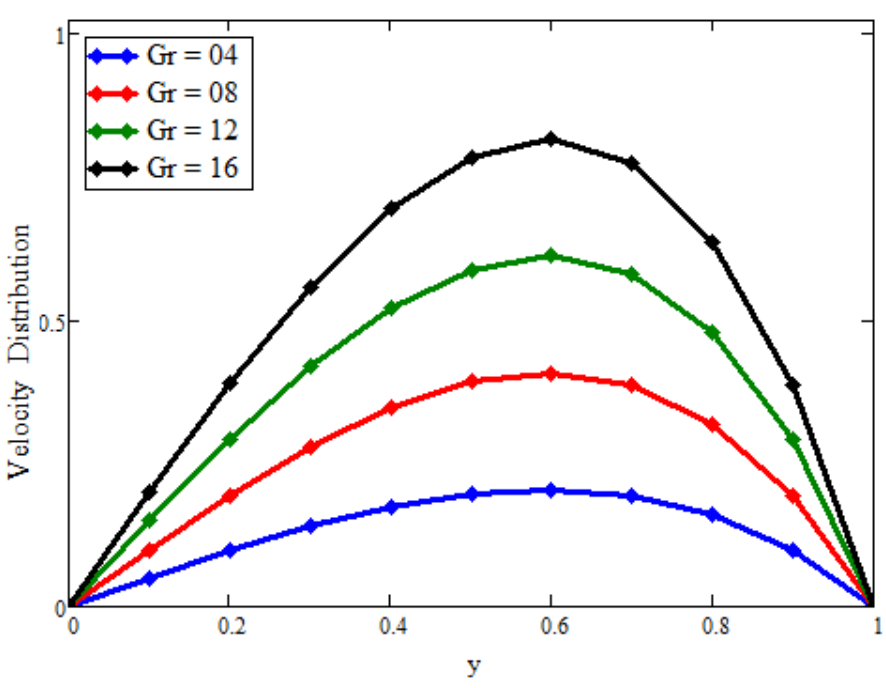
Figure 12. Velocity distribution against y due to Gr , when Pr = 6.2, φ hnf = 0.04, t = 3, M = 0.1, α = β = γ = 0.5.